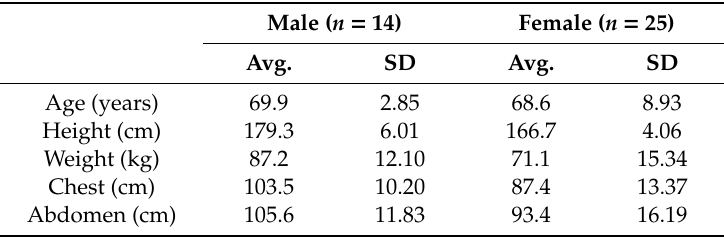
Table 2. Baseline characteristics of the